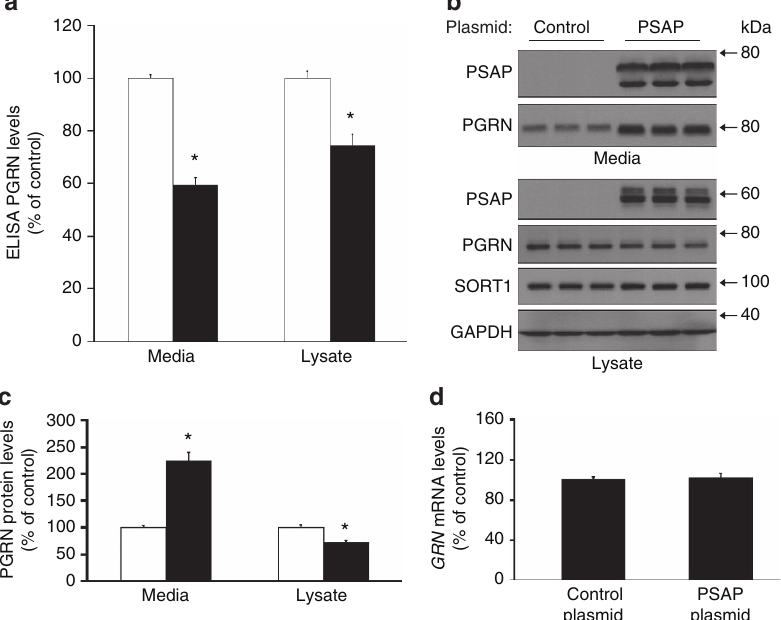
Figure 6 | PSAP overexpression yields conflicting PGRN measurements by ELISA and immunoblotting. ( a ) R&D ELISA PGRN measurements in the media and cell lysates of HeLa cells after overexpression of a GFP control (white bars) or PSAP (black bars; n Z 12 per group). ( b ) Immunoblot of media and lysates from HeLa cells post control plasmid or PSAP overexpression. ( c ) Quantification of PGRN immunoreactivity from immunoblots of HeLa cell media and lysates after transfection with either a control (white bars) or PSAP (black bars) plasmid ( n Z 12 per group). ( d ) Quantification of GRN mRNA levels in HeLa cells post PSAP overexpression ( n Z 8 per group). In all graphs, the values represent the mean ± s.e.m. *Differs from controls, P o 0.0001 by Student’s t